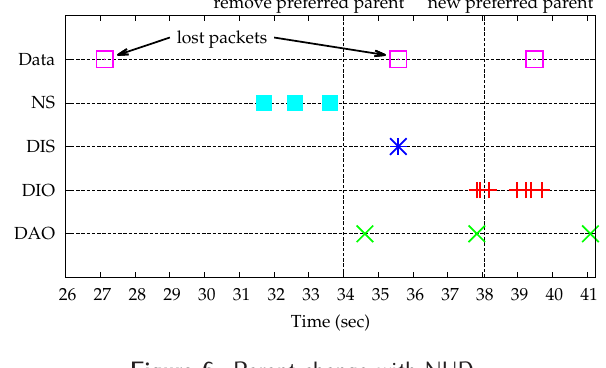
Figure 6. Parent change with NUD How the mobile node uses NUD to change parent its preferred parent is more clear in Fig. 6. Each dot represents the transmission or reception of a message at the time indicated on the X-axis, while message types are reported on the Y-axis. Results presented in this figure are extracted from one of the most representative trials in Strasbourg. In Fig. 6, reachability is confirmed just before the fixed node, acting as the mobile node preferred parent, stops serving the mobile node (at t = 0 sec). After 31 s , the mobile node moves to the probe state of NUD and sends 3 neighbor solicitations to its current preferred parent. After no response, the preferred parent is considered as unreachable, triggering the reset of the parent set and the transmission of new multicast DIS. Upon reception of new DIO, the mobile node selects a new preferred parent and reconnects to the graph. In this example, the mobile node was disconnected from the graph during 38 . 05 s Figure 5. Average disconnection time from parent As we can see, MT-RPL shows the lower disconnec- tion times in both Strasbourg and Grenoble sites. The large disconnection times observed for NUD (between 31 and 47s for one-quarter of the measurements in Strasbourg) is due to the moment when the mobile node